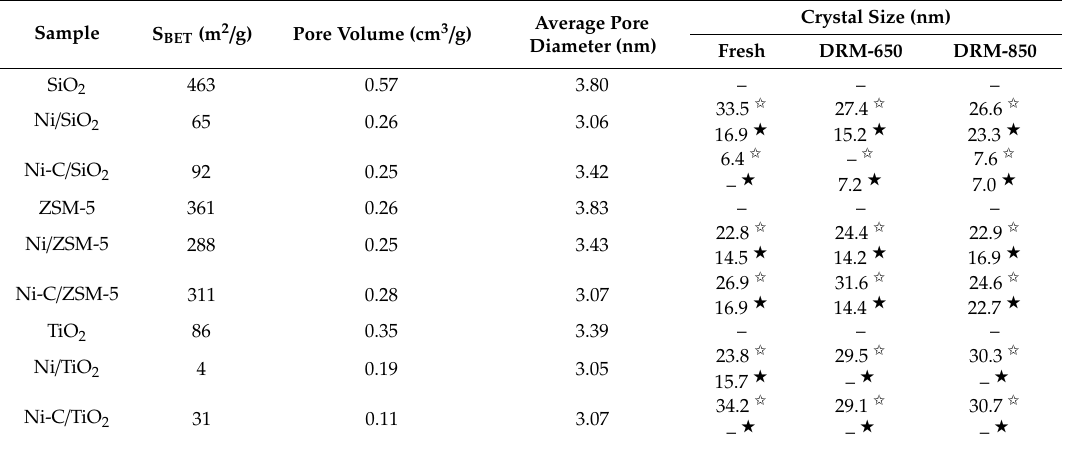
Table 1. Textural characteristics of the reduced and spent